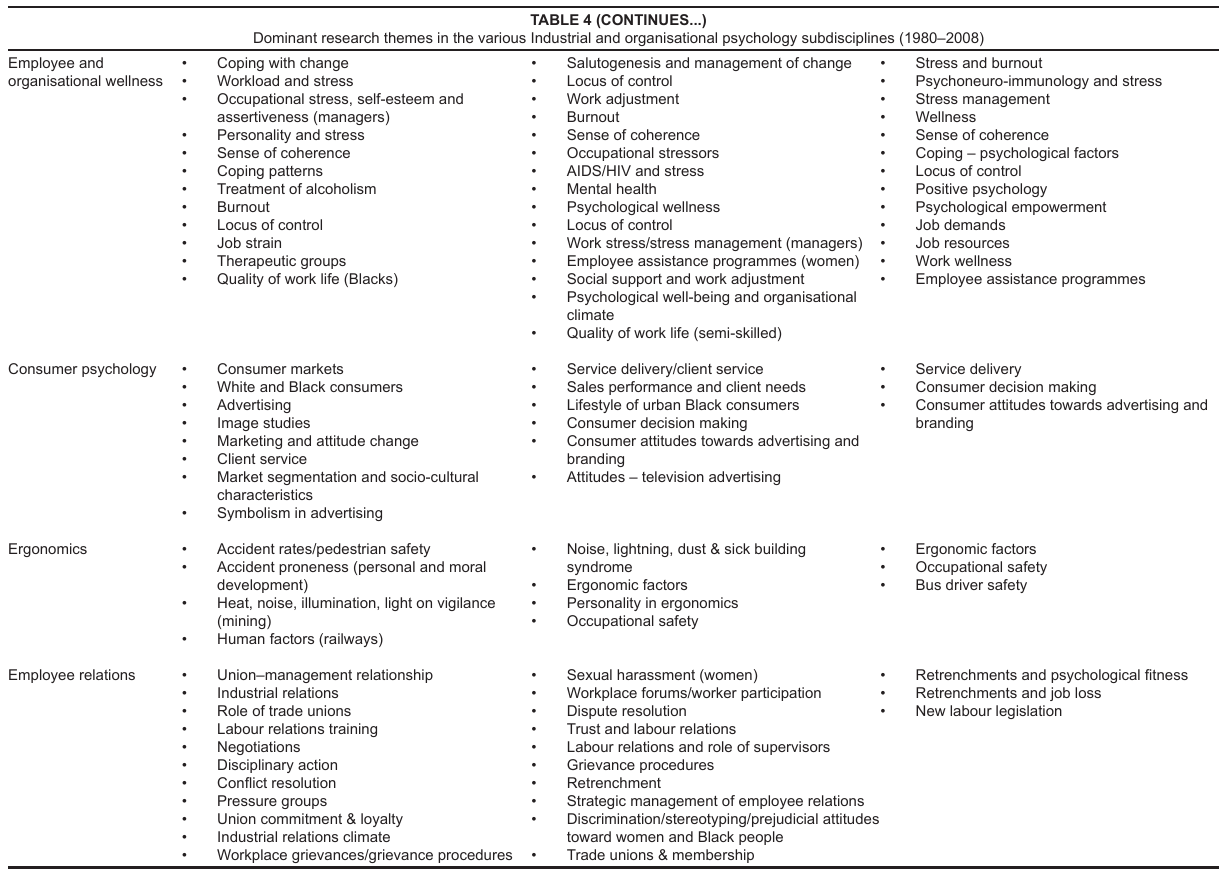
TABLE 4 (CONTINUES...) Dominant research themes in the various Industrial and organisational psychology subdisciplines